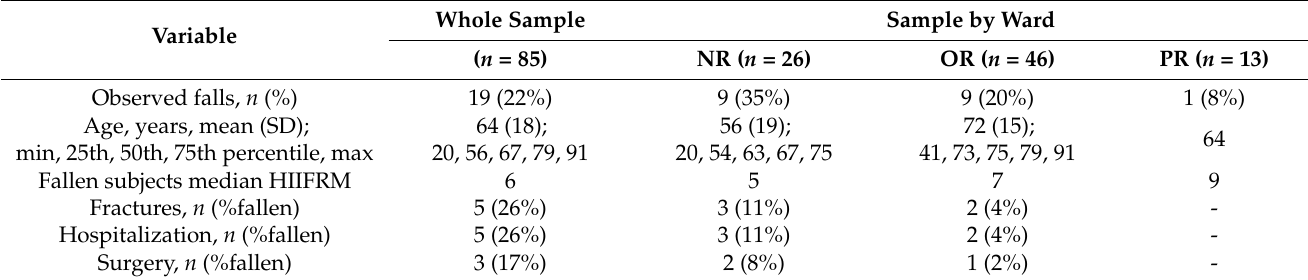
Table 3. Fallen subjects characteristics and falls consequences at the 6-month mark after discharge.